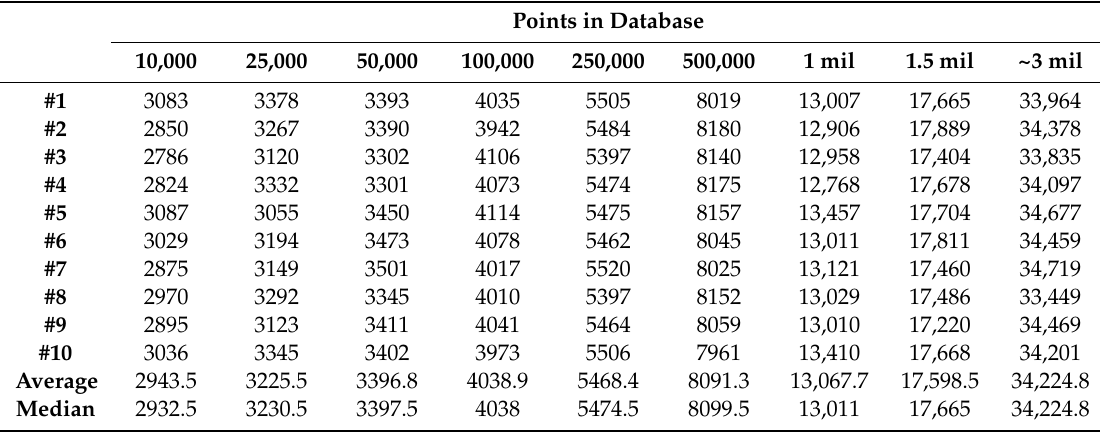
Table 5. Results of testing Mapbox GL JS (Graphics Library JavaScript) (values in milliseconds).